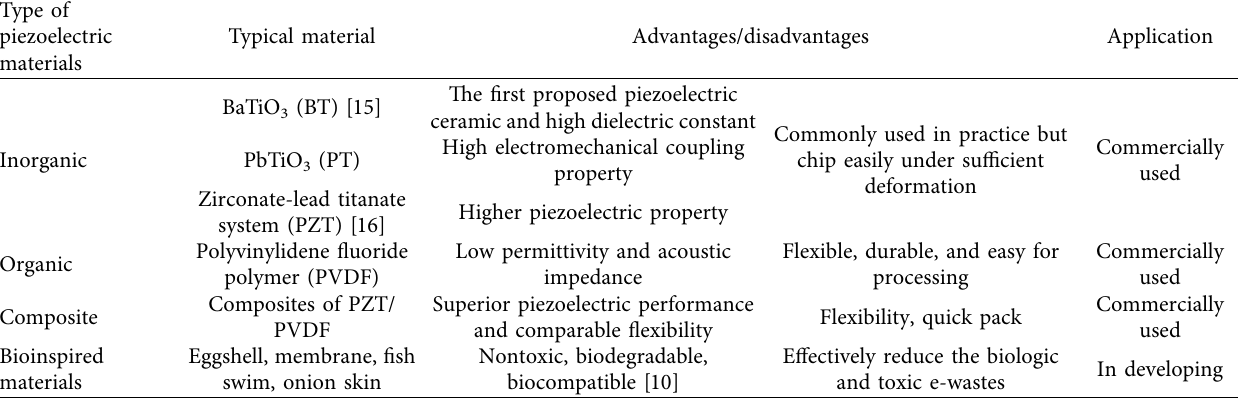
Table 1: Comparison of four typical piezoelectric